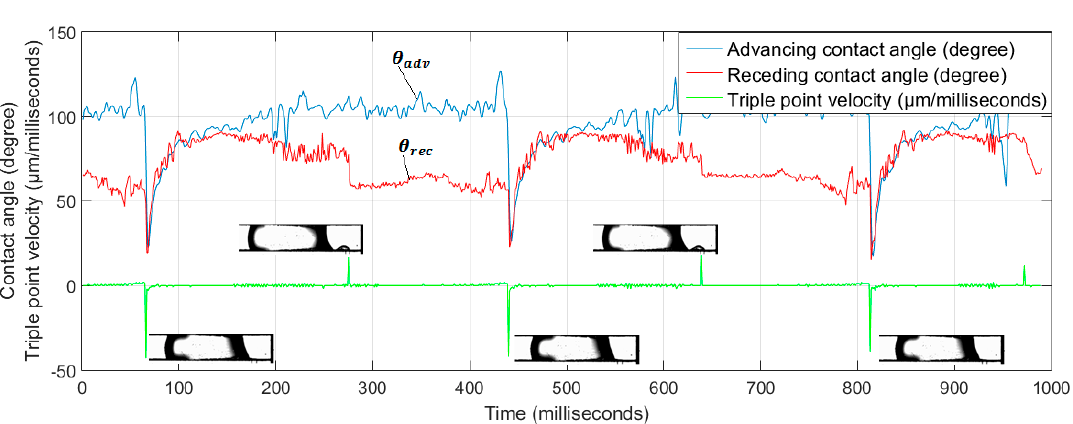
Figure 22. Time evolution of triple-point velocity, slug formation and detachment, and dynamic contact angles during slug flow.